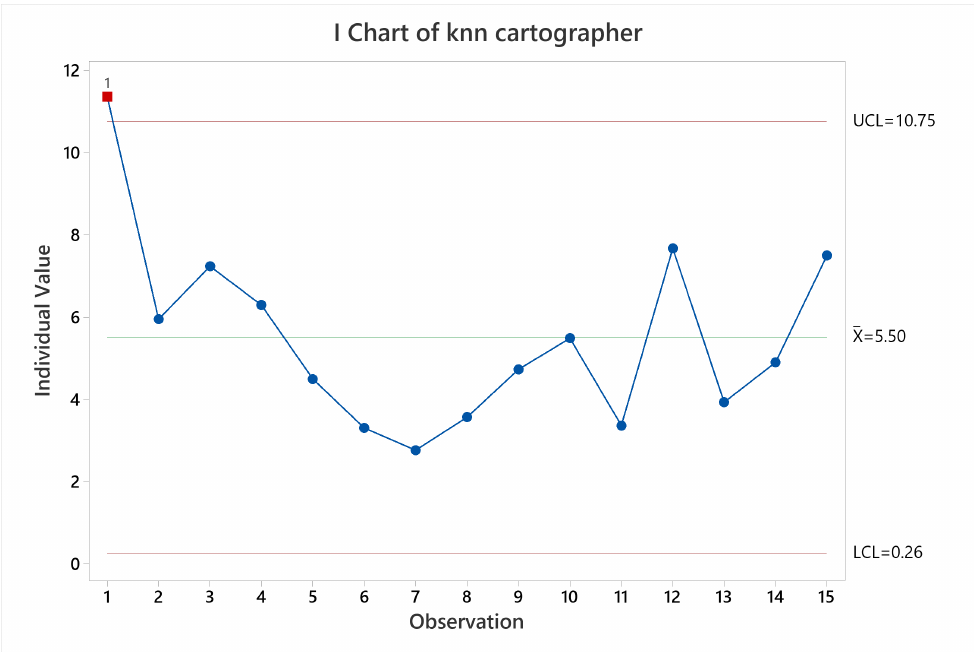
Figure 14. Map accuracy mean behavior for Cartographer.